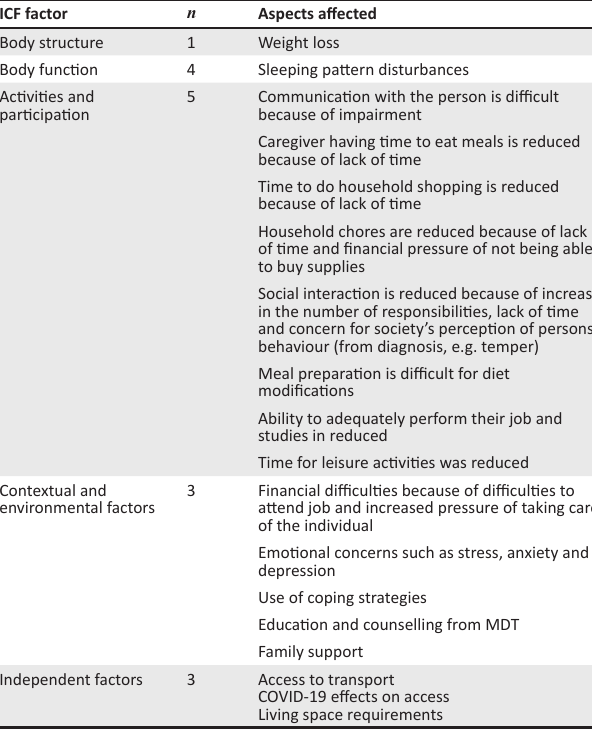
TABLE 3: Findings from participants relating to the International Classification of Function and Disability model ( N = 5). ICF